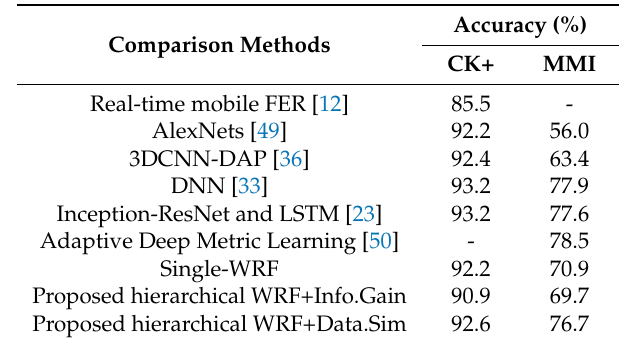
Table 1. Comparison of the proposed method with state-of-the-art methods 1 .